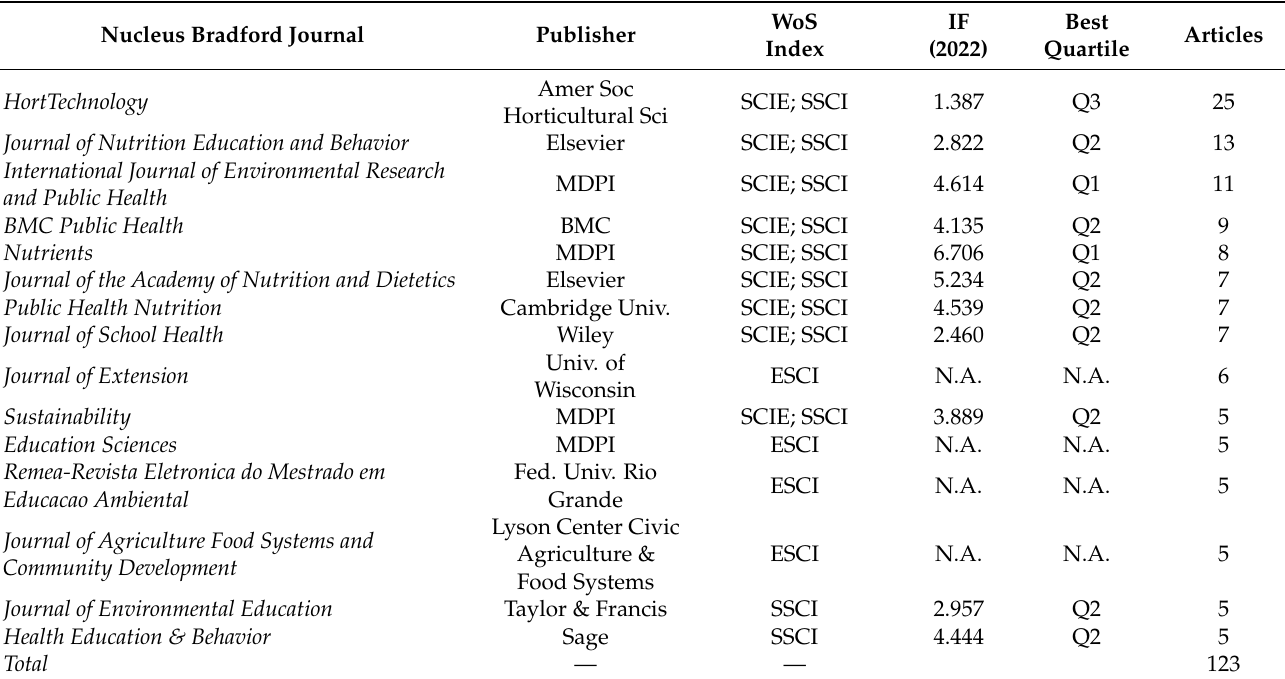
Table 3. Main journals publishing on school gardens (over five